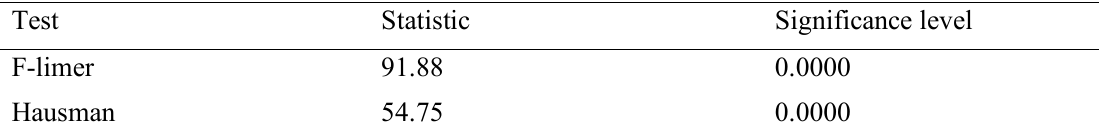
Table 3 . F-limer and Hausman test Results